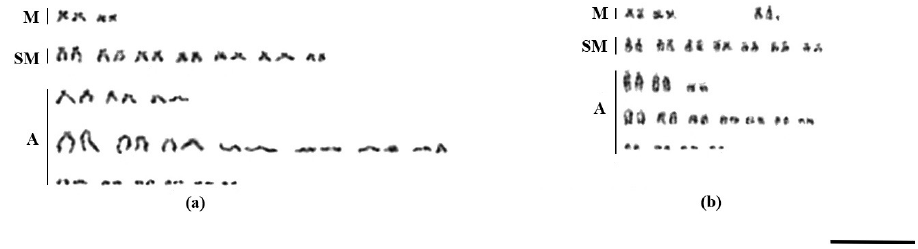
Figure 3. Karyotypes of Nothobranchius sp. ‘Kasenga’ a somatic chromosomes of female b somatic chro- mosomes of male (M – metacentric chromosomes, SM – submetacentric chromosomes, A – acrocentric chromosomes). Scale bar: 10